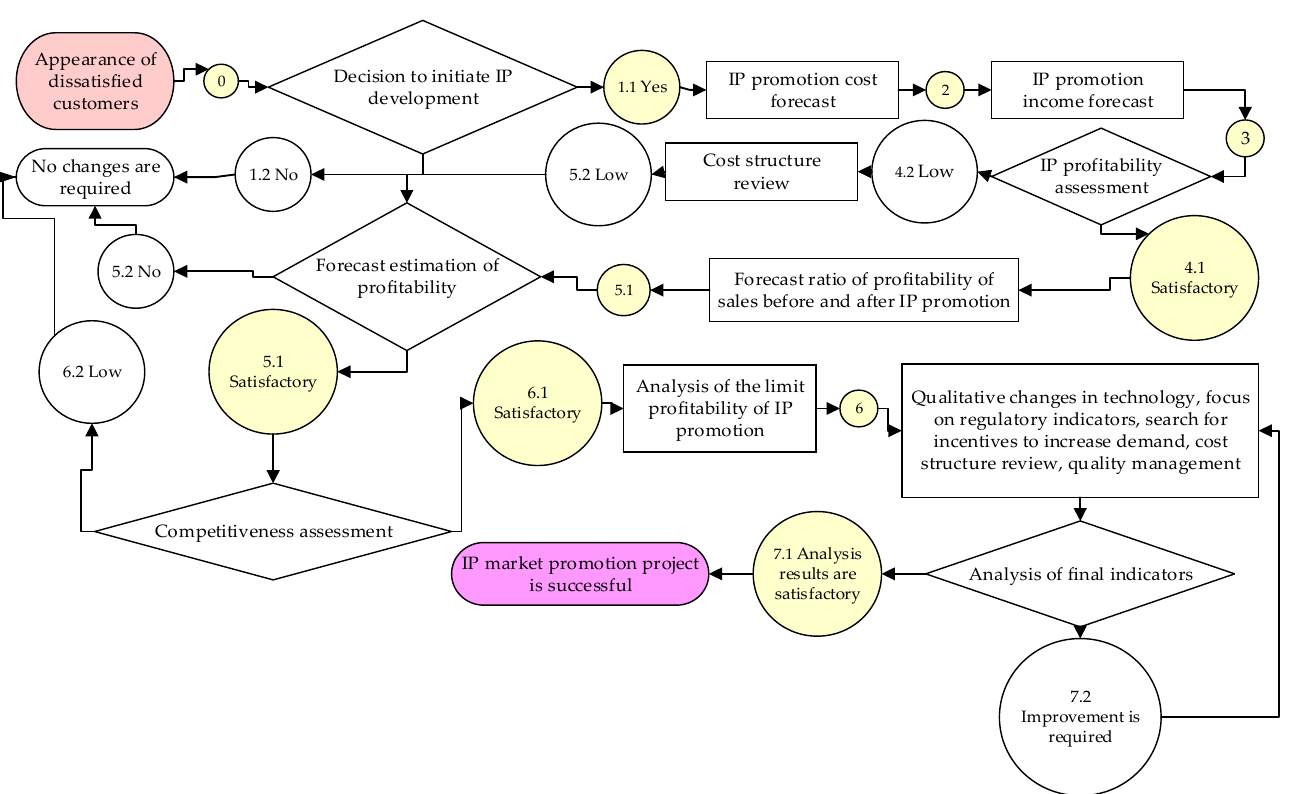
Figure 3. Flow diagram for assessment of management cost ‐ effectiveness of market promotion pro ‐ cess of innovative products, color notations: —as ‐ sessment process, other figures correspond to the postulates of “algorithm and data structure” (au ‐ thor’s research).